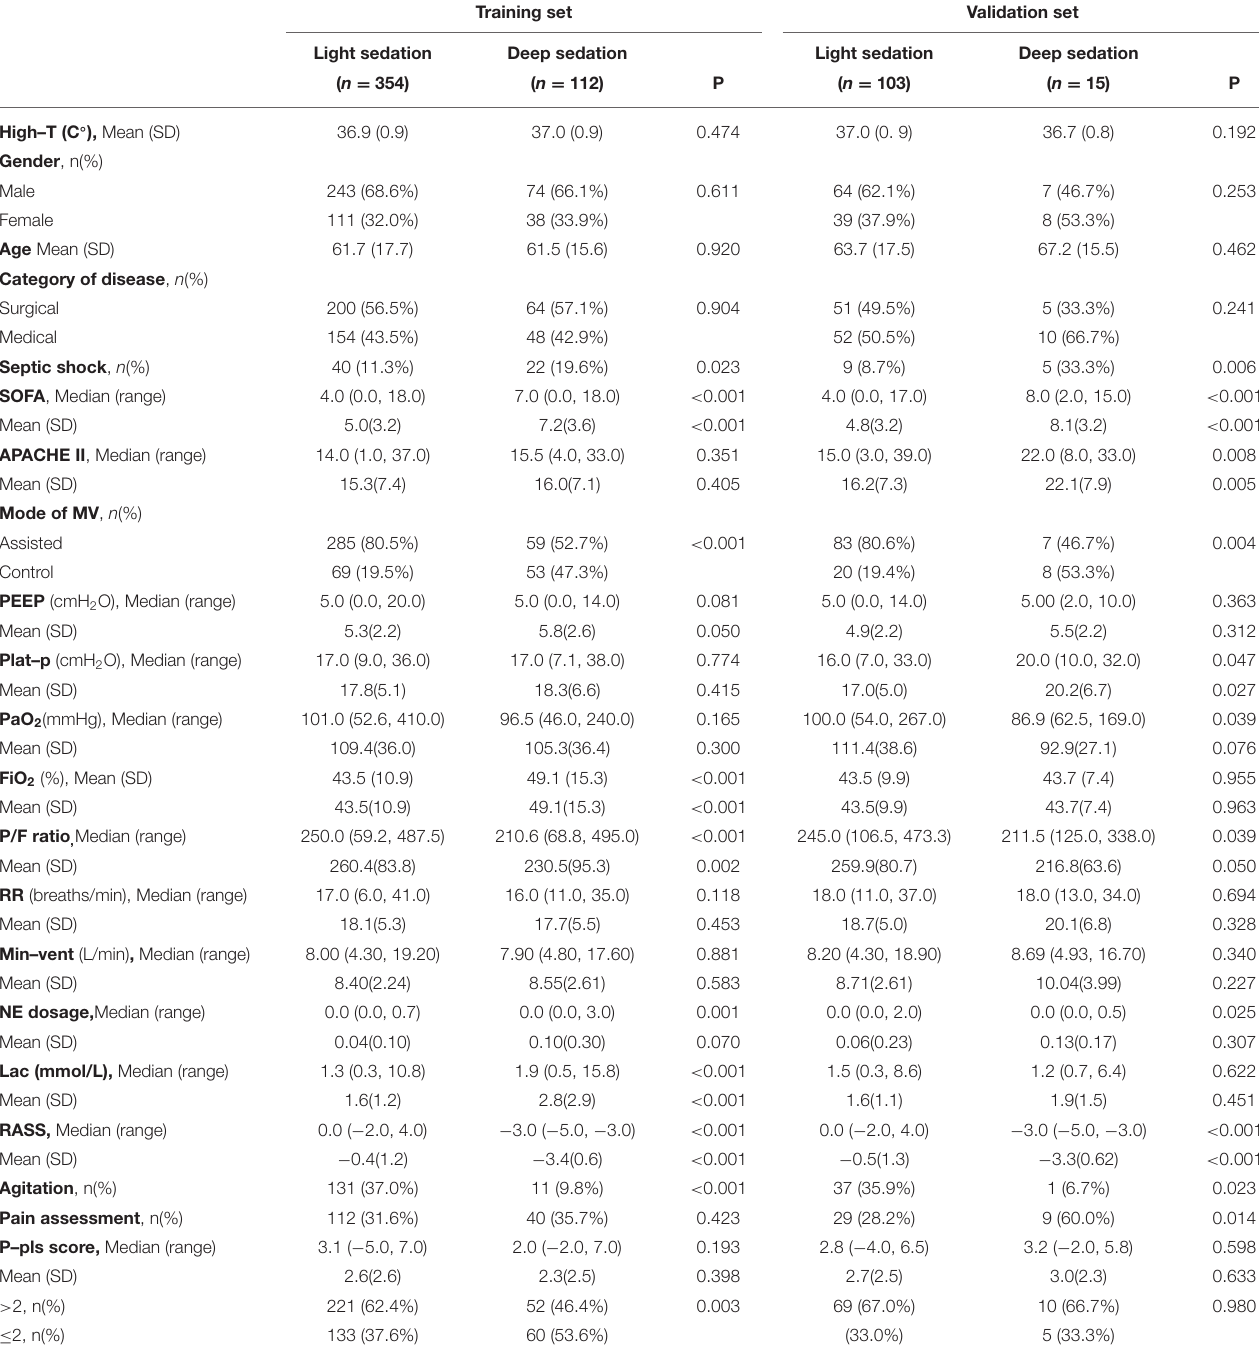
TABLE 1 | Baseline characteristics of mechanically ventilated (MV) patients in the training set and the validation set. Training